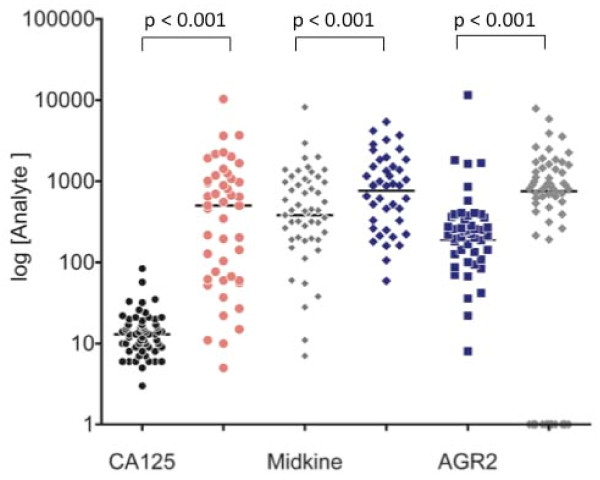
Plasma biomarker concentrations. The median plasma concentration within each group (normal women (controls) n = 61 and women with ovarian cancer (cases) n = 46) is represented by the horizontal line. Biomarker concentrations were significantly greater in case cohorts (solid symbols) when compared to their respective control cohort (open symbols) (p < 0.001, Mann Whitney tests). Data are presented as log (plasma concentration). CA125 as U/ml; and MDK and AGR2 as pg/ml.